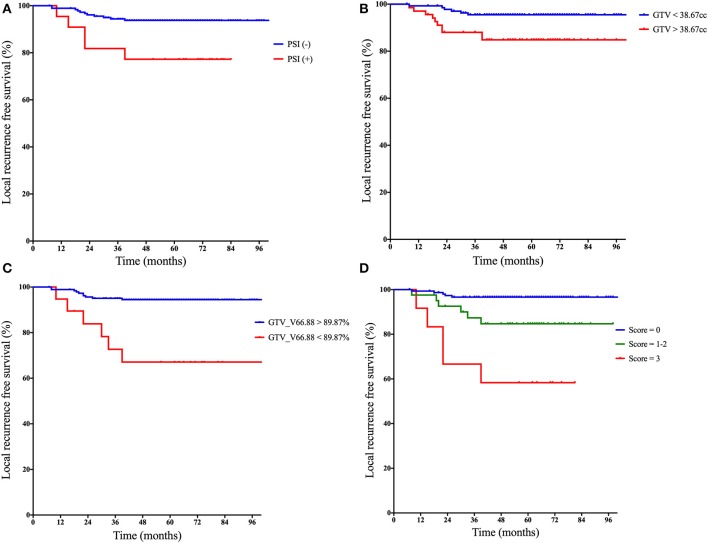
Kaplan–Meier curves of local recurrence-free survival based on: (A) the status of PSI, (B) categorical GTV, (C) categorical V66.88 for GTV-P, and (D) the prognostic scores derived from the quantification of following risk factors: (1) paranasal sinus invasion-positive, (2) GTV > 38.67 cm3, and (3) V66.88 for GTV <89.87%. PSI, paranasal sinus invasion; GTV, gross tumor volume; V66.88, target volume covered with dose over 66.88 Gy.